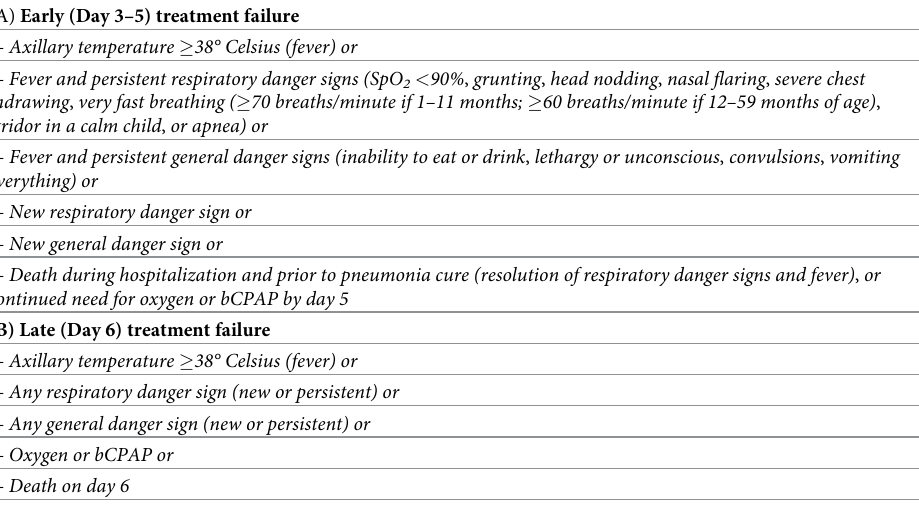
Table 1. Antibiotic treatment failure